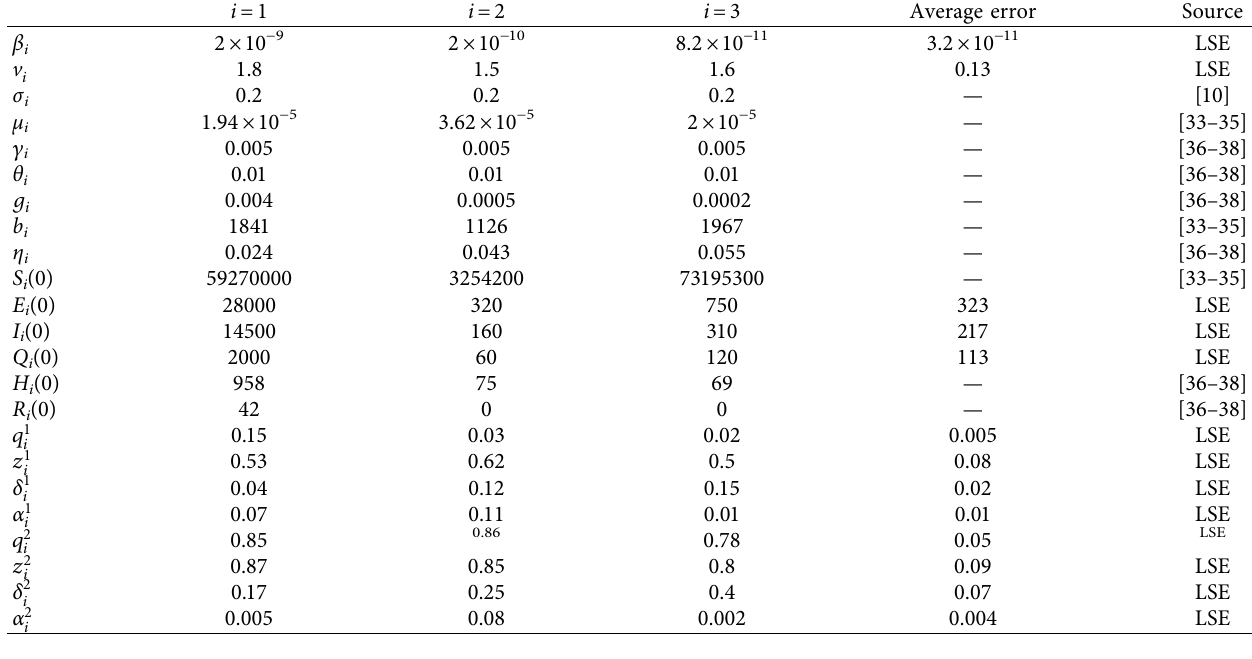
Table 1: Parameter data and sources of Hubei province, Chongqing, and Hunan province,